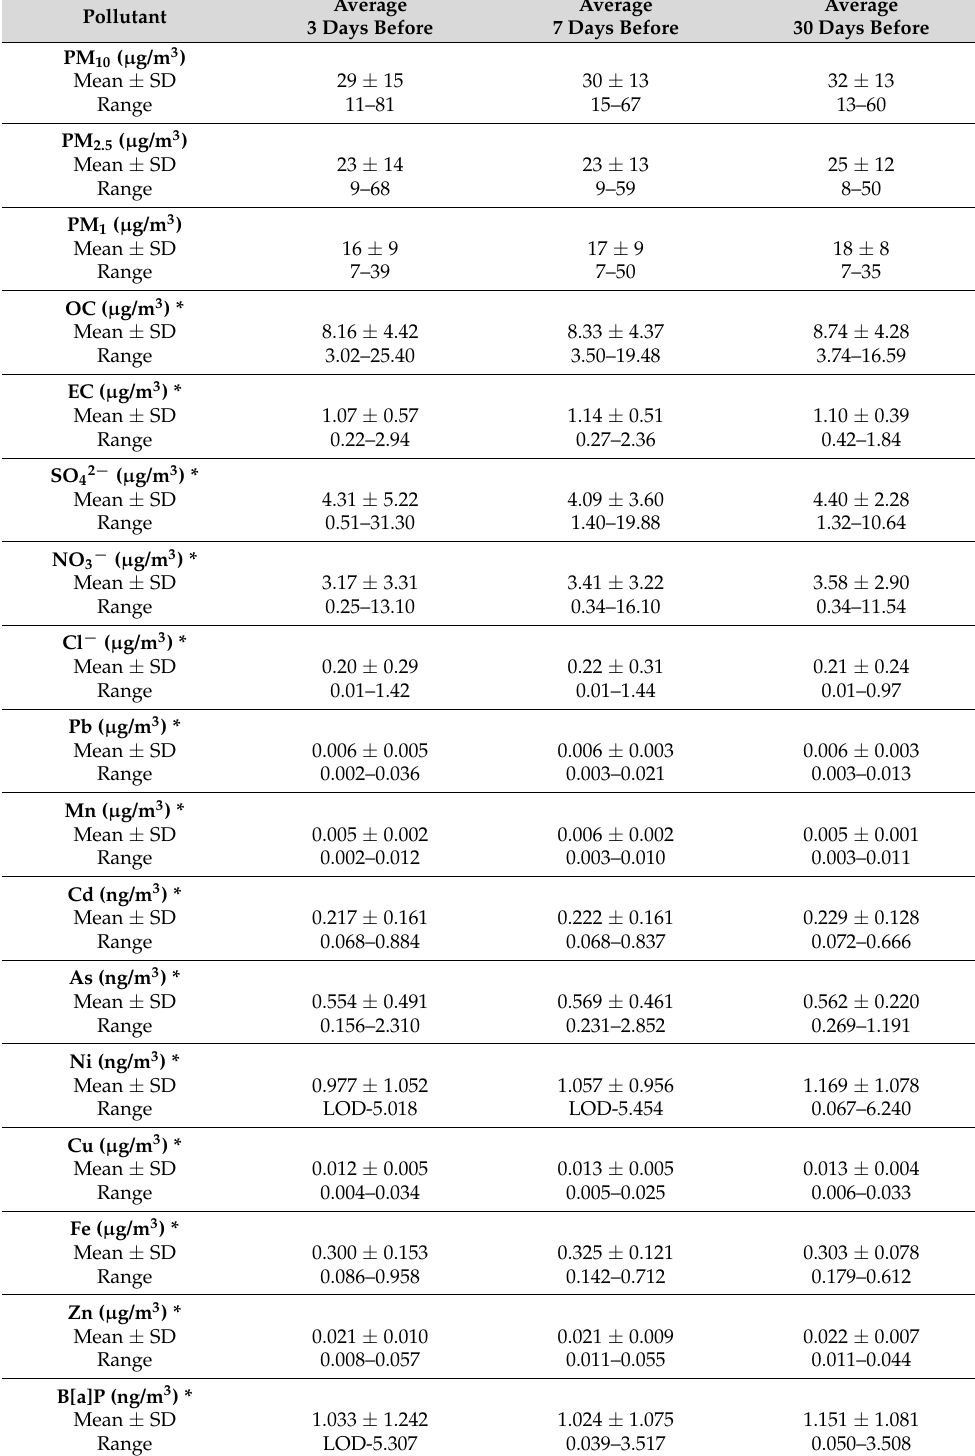
Table 3. Air pollution exposure of participants during different time windows (3, 7, and 30 days before blood